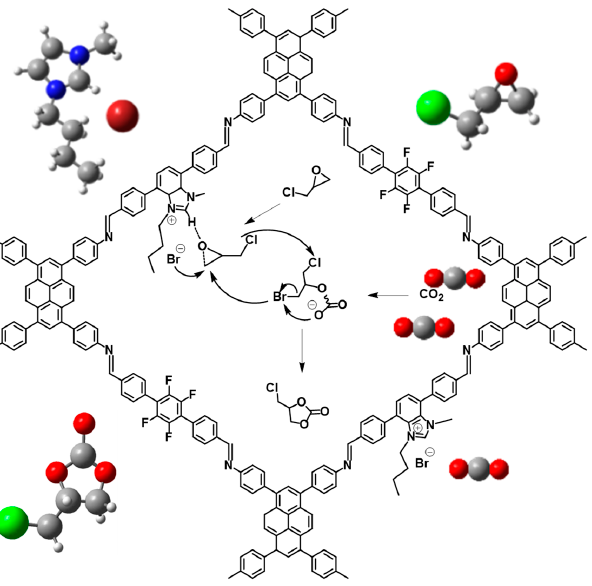
Figure 5. Scheme of possible catalytic mechanism for the reaction of epoxides and CO 2 into cyclic carbonates catalyzed by BMIM4F-Py-COF. carbonates catalyzed by